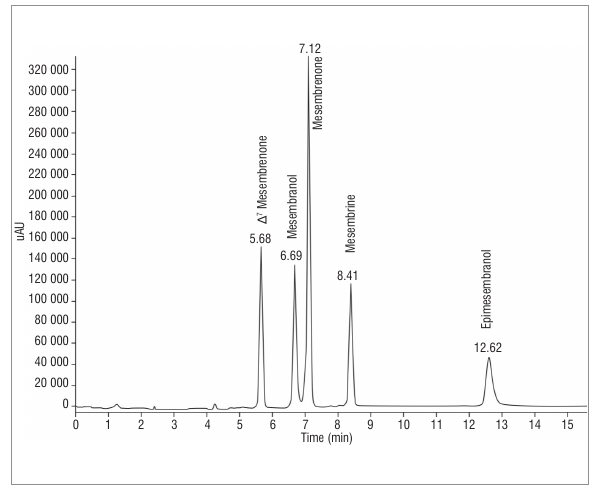
Figure 2 : A chromatogram derived from high-performance liquid chroma- tography with UV of standard alkaloids found in Sceletium .